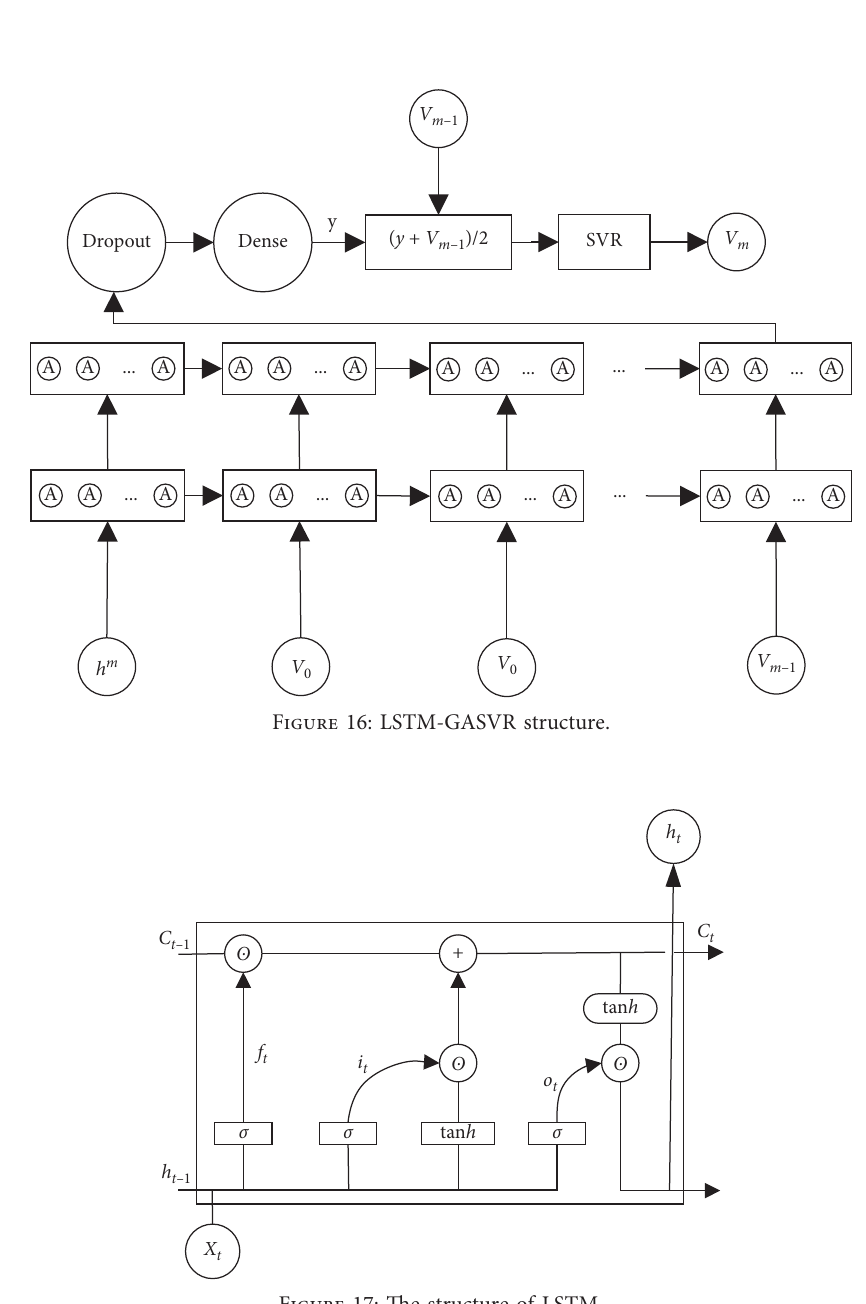
Figure 17: The structure of